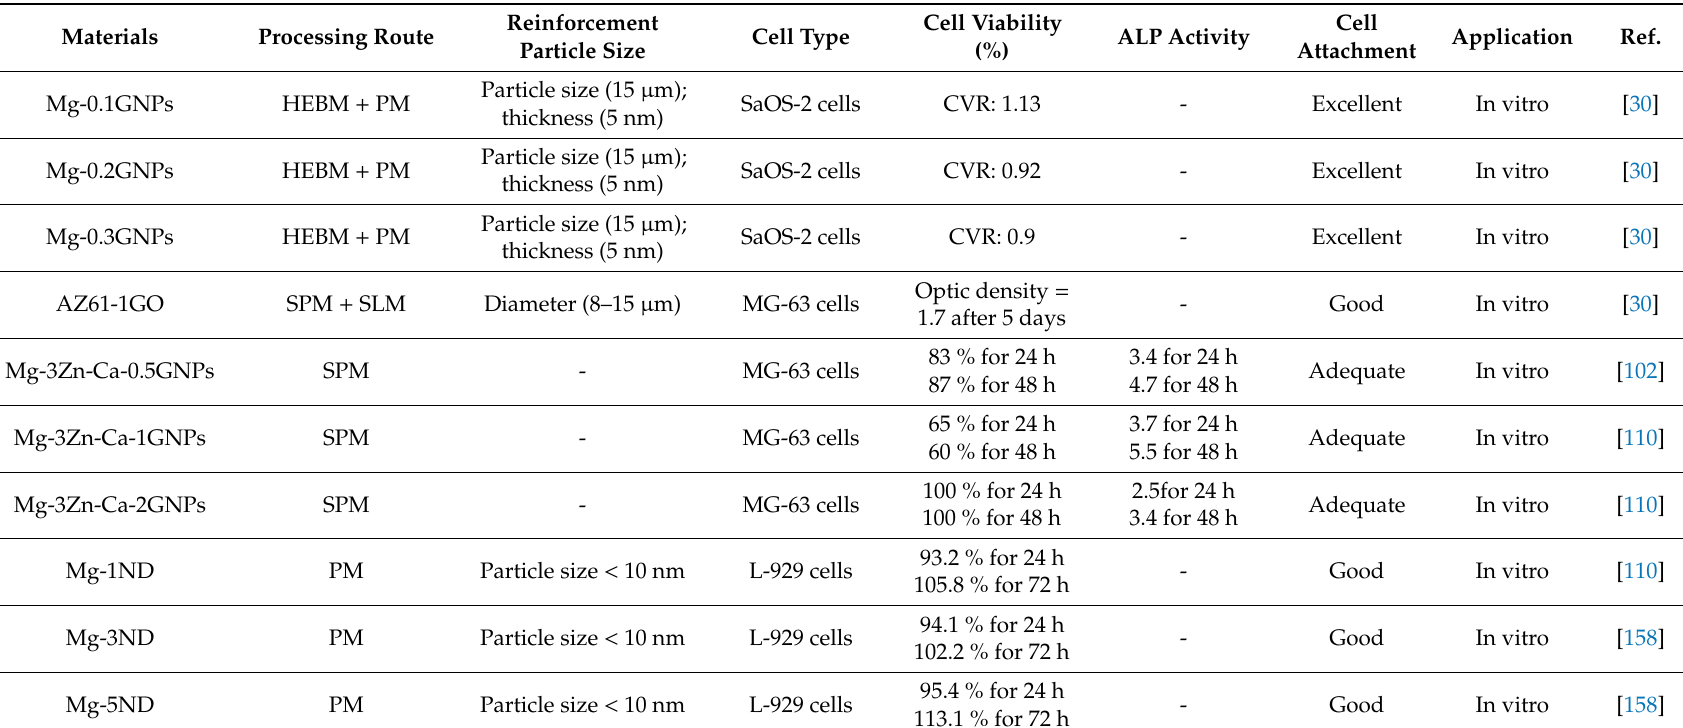
Table 4. The cellular characterization in Mg-GFN-based